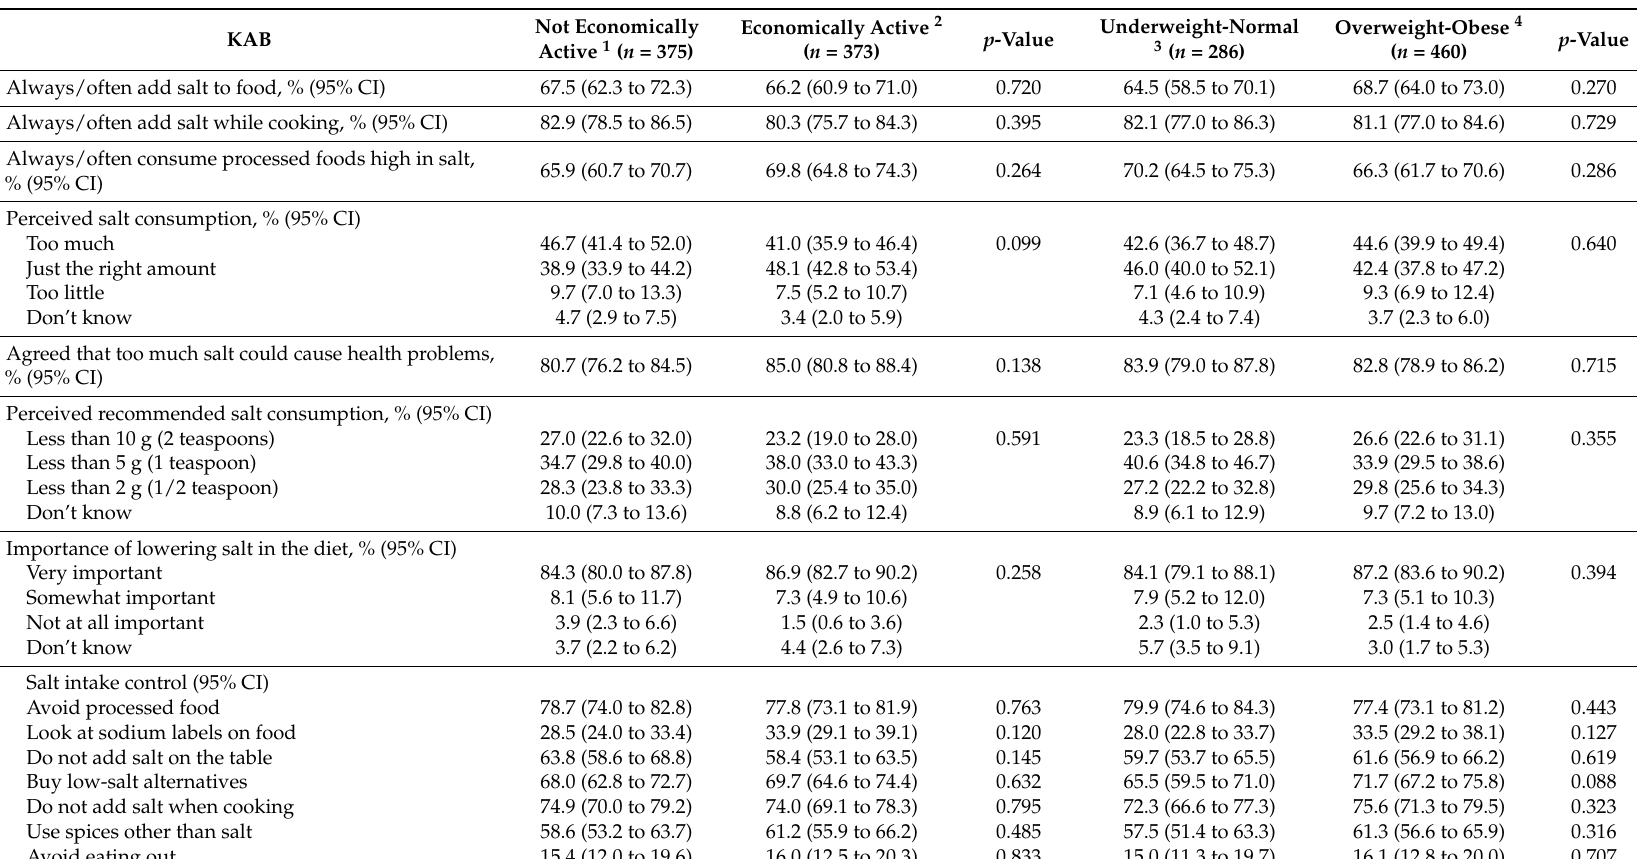
Table A1. Weighted knowledge, attitudes and behavior (KAB): Results of subgroup analyses for economic activity and body mass index. KAB